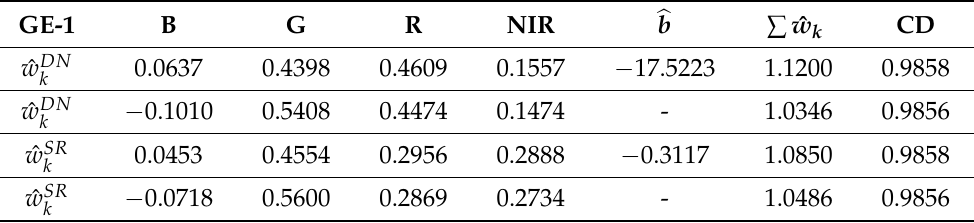
Table 3. MMSE coefficients of the multivariate linear regression between interpolated MS bands and lowpass-filtered Pan, both in either DN or SR format, for the GeoEye-1 Collazzone image. The bias, (cid:98) b , is either set equal to zero or left as a further variable to